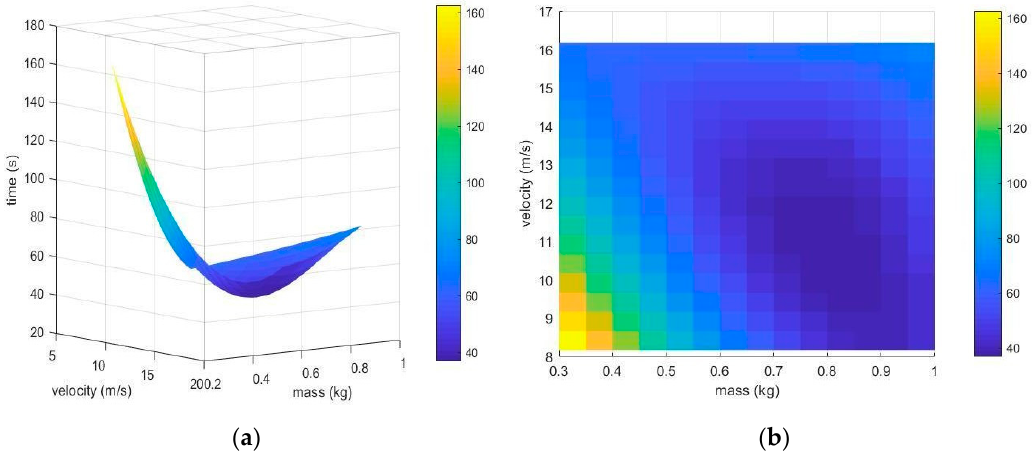
Figure 2. Side view of t 50 profile ( a ), top view of t 50 profile ( b ).